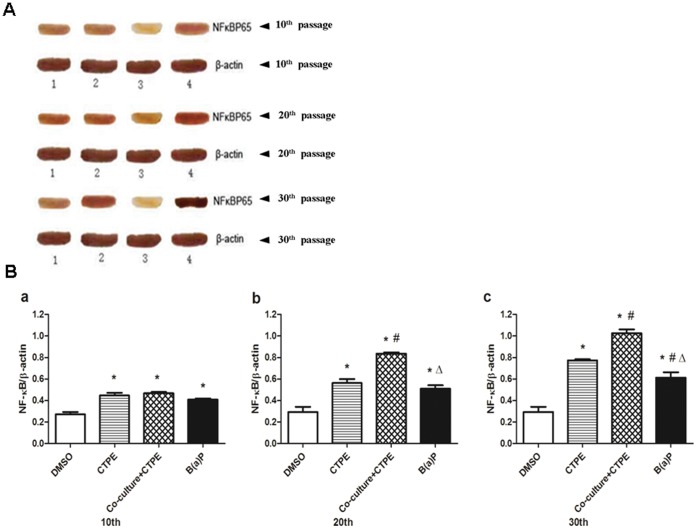
The protein levels of NF-κB in the BEAS-2B cells at passages 10, 20 and 30.(A) The protein bands of NF-κB in the BEAS-2B cells at passage 10, 20 and 30 in four groups were shown by Western blot. 1–4 bands: B(a)P, CTPE, DMSO, Co-culture+CTPE. (B) Quantitative comparison of the densitometry of NF-κB protein bands intensities normalized to the loading control β-actin. The level of the relative densitometry of NF-κB protein in Co-culture/CTPE group started to increase at passage 10, which was higher than that of CTPE or B(a)P at passage 20, and kept the highest level at passage 30.(n = 6, *: vs DMSO, P<0.05; #: vs CTPE, P<0.05; Δ:vs Co-culture+CTPE, P<0.05). There are representatives from two similar experiments.